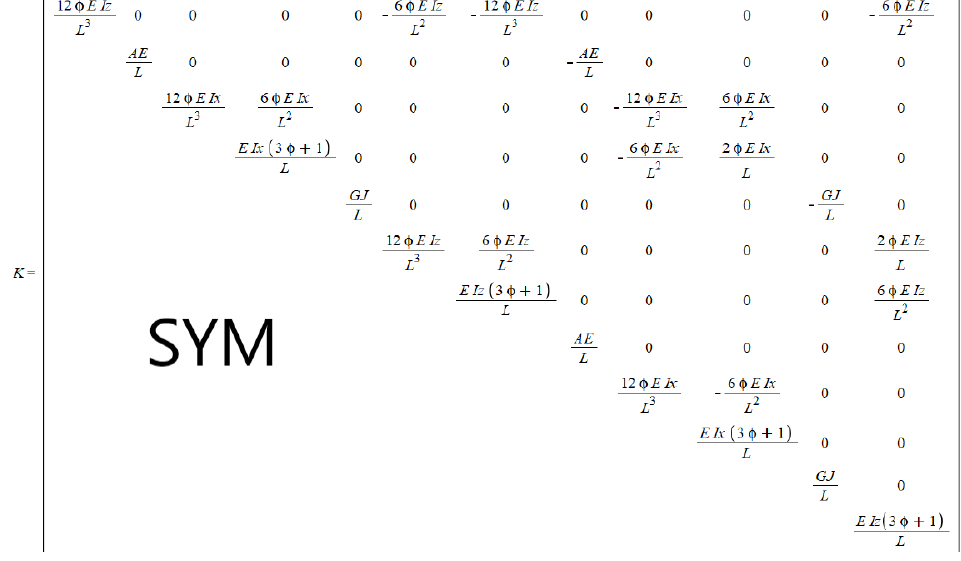
Figure A2. Ful Timoshenko’s stiffness matrix (6 DOF per node). Note: the matrix is symmetric, and the shear factor depends on the direction of the bending, that is, as a function of Iz e Iy .